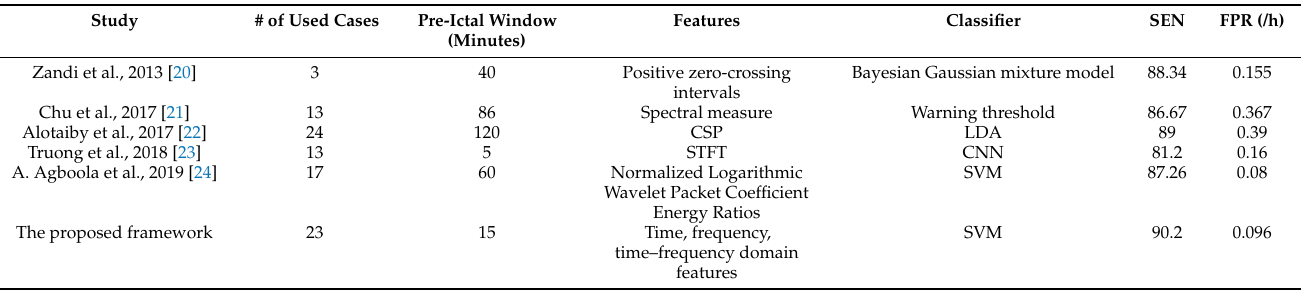
Table 6. Comparison with prior